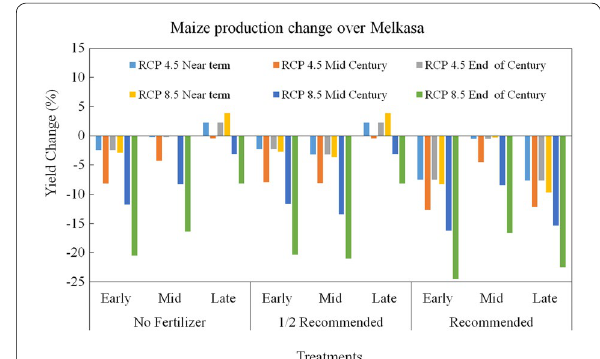
Fig. 6 The simulated maize yield in near term, mid and end of century at Melkassa